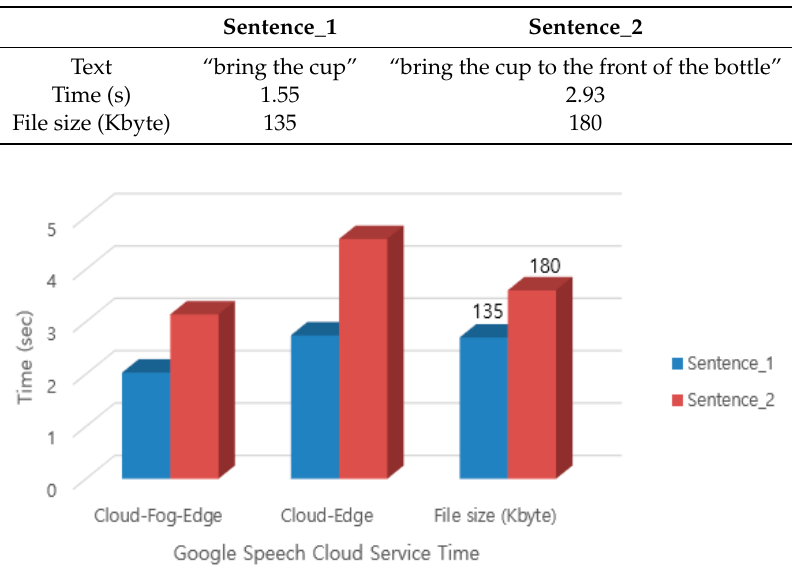
Figure 10. Google speech cloud service time according to the fog service model.